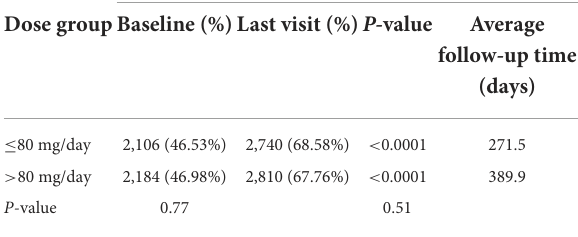
TABLE 7 Alcohol consumption in Group 2.